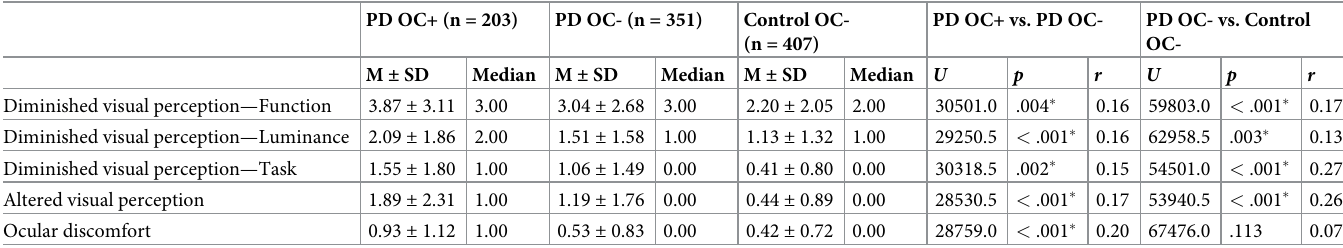
Table 6. Subscale scores of people with and without an ophthalmological condition, with Mann-Whitney U test results.